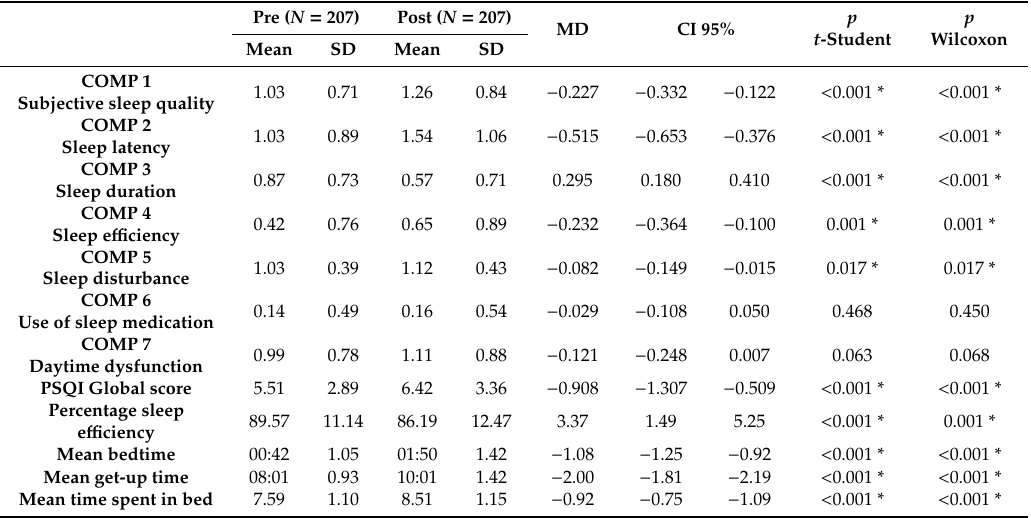
Table 2. Changes in the sleep components analyzed during lockdown. Parametric and nonparametric bivariate